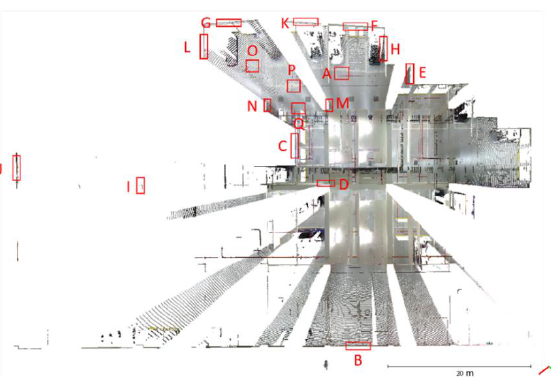
Figure 6. Locations of the selected 17 planes (labeled A to Q) for calibration reference data. Table 3. Fitting plane